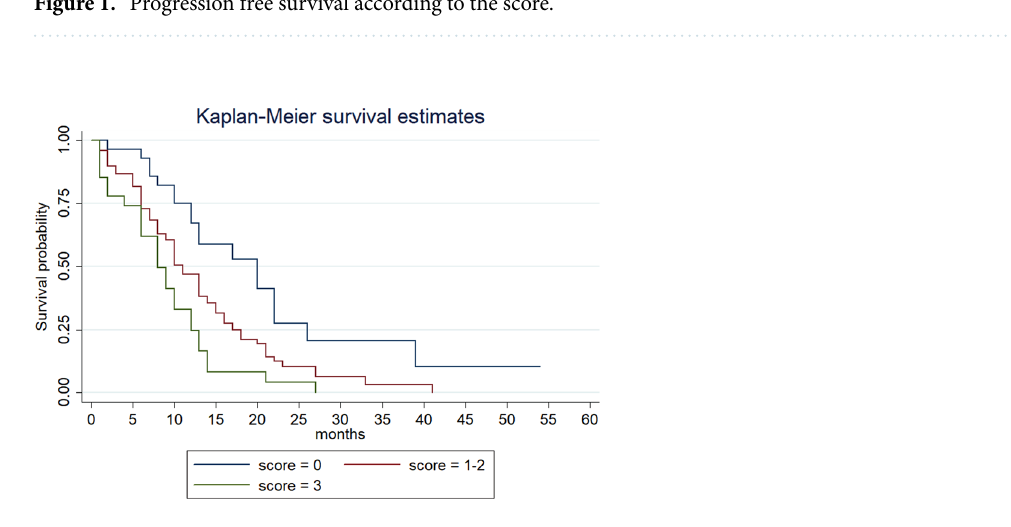
Figure 1. Progression free survival according to the score.